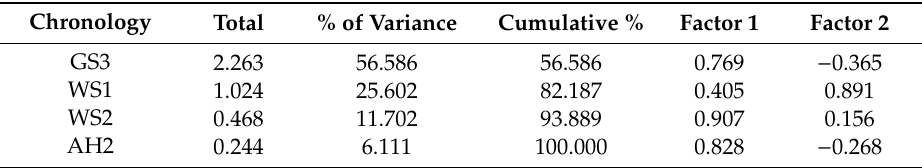
Table 4. Factor loadings of principal components from PCA of the TRW chronologies of the Ili River